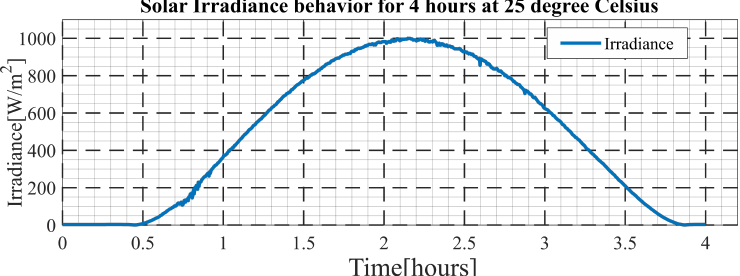
Figure 21. Illustration of the irradiance behavior for 4 h at 25 degree weather temperature.